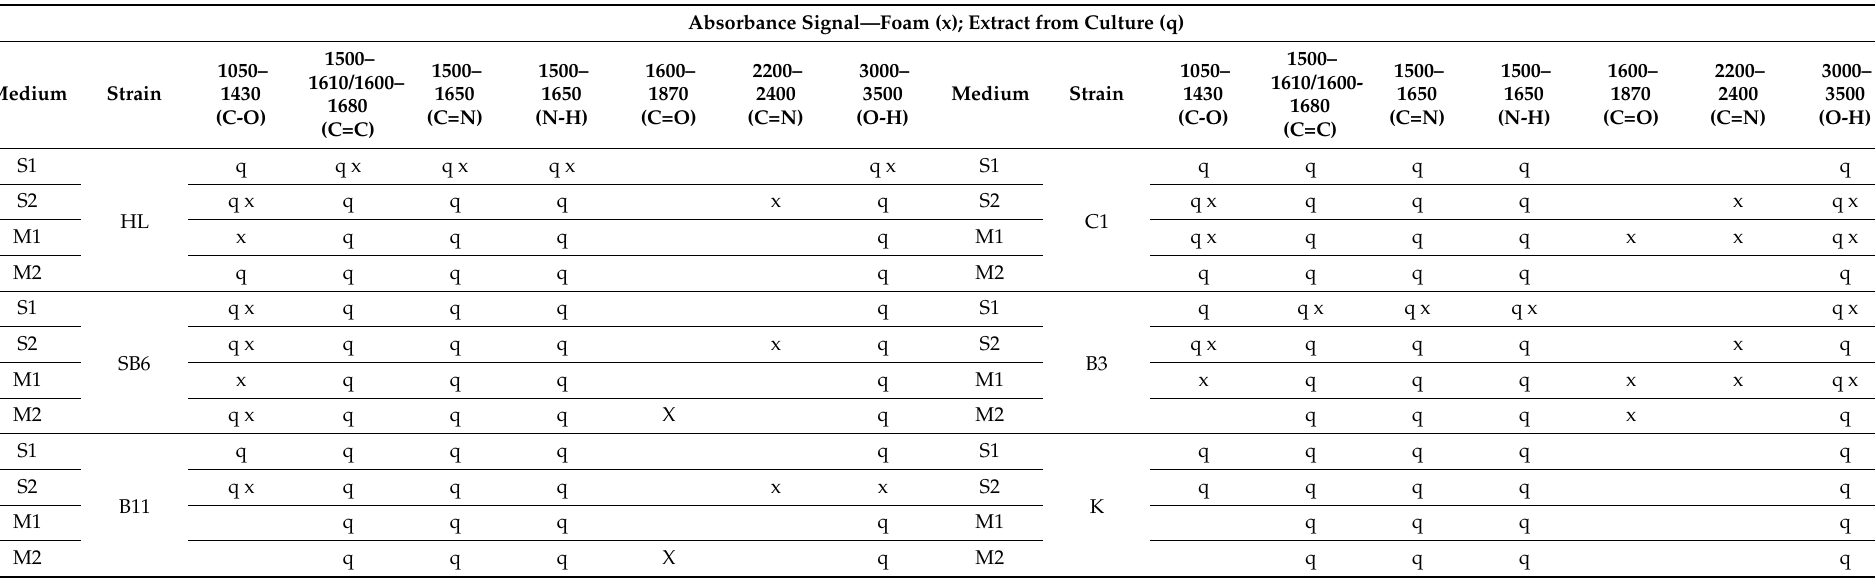
Table 2. Infrared spectroscopy results—occurrence of signals at specified wavenumbers; cultures organic extract (q) and culture fluid foam (x) of T. citrinoviride HL, C1, B3, B11; T. atroviride SB6 and T. harzianum in Saunders (S1, S2) and MGP (M1, M2)